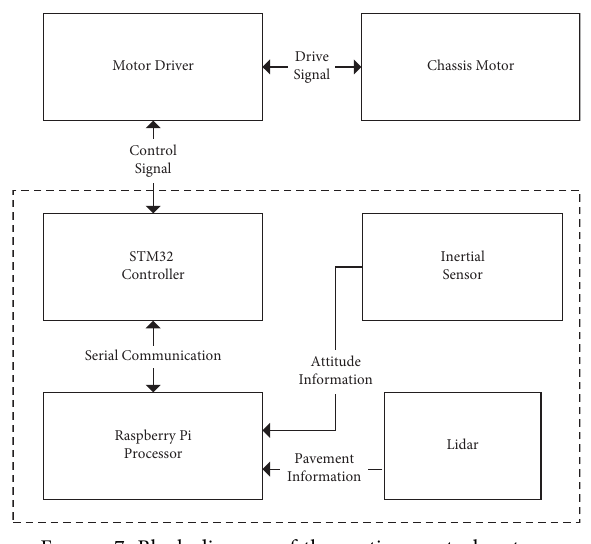
Figure 7: Block diagram of the motion control